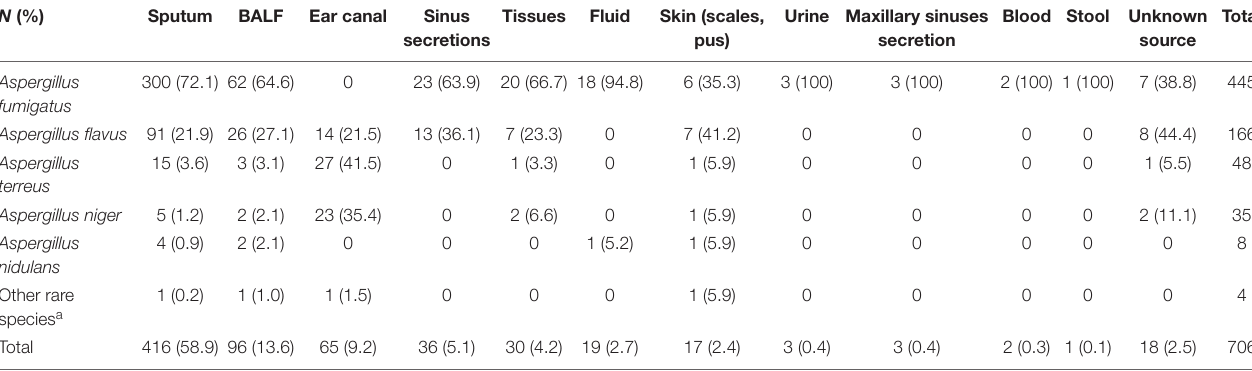
TABLE 1 | Aspergillus spp. isolates recovered from clinical